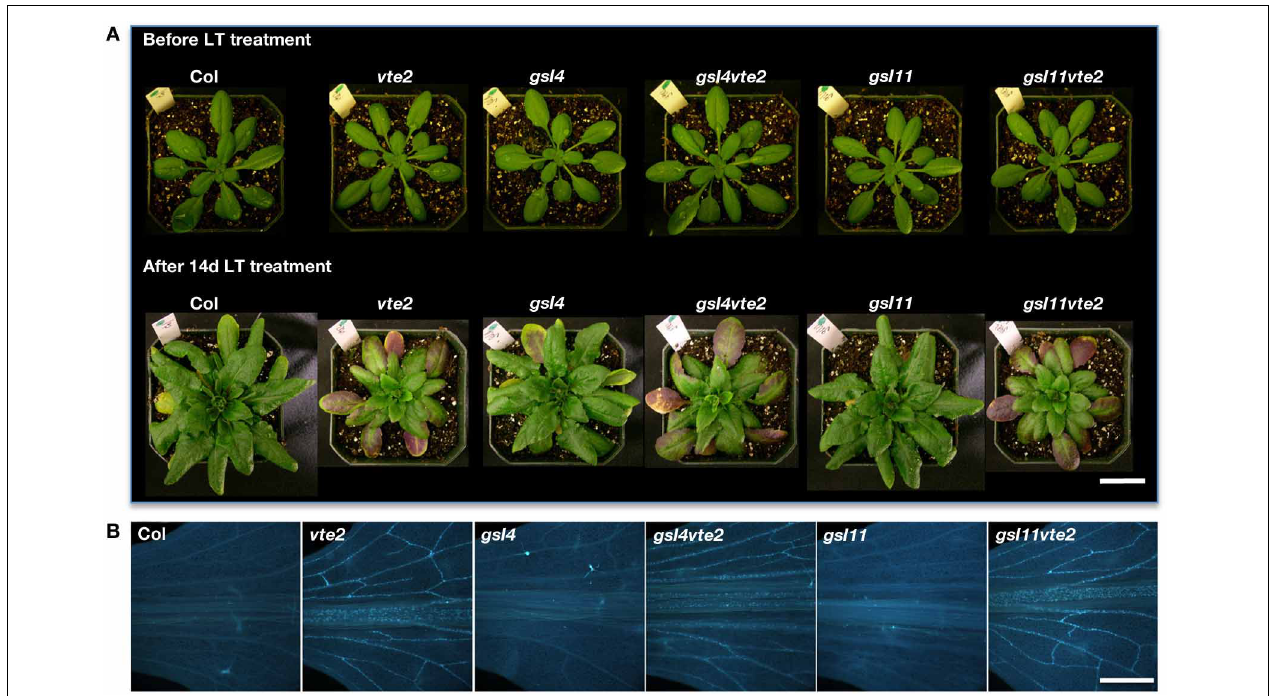
FIGURE 4 | Whole plant and vascular callose phenotypes of Col, vte2 , gsl4 , gsl4 vte2 , gsl11 , and gsl11 vte2 . All genotypes were grown under permissive conditions for 4 weeks and then transferred to LT conditions for the specified periods previously shown to maximize each phenotype (Maeda et al., 2006). (A) Whole plant phenotype of the indicated